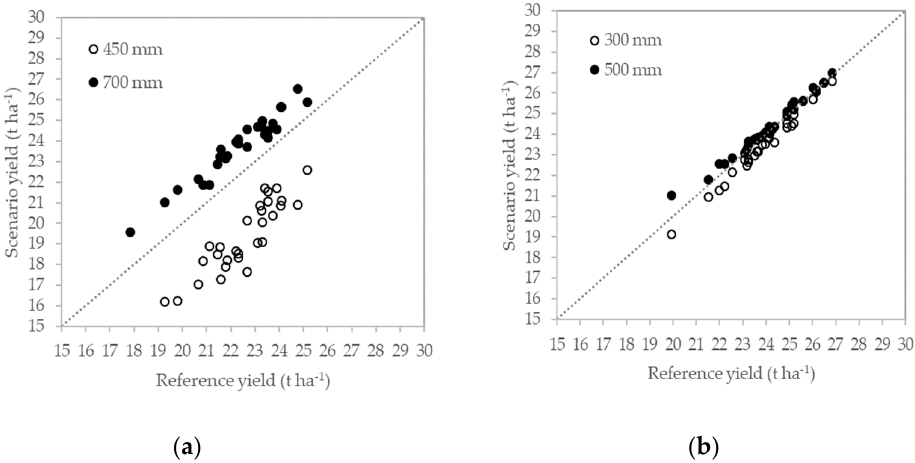
Figure 10. Comparison of potential dry root yield at harvest under different irrigation water allocation scenarios (scenario yield) with potential dry root yield at harvest under the normal irrigation water allocation (reference yield) for the 30 simulated seasons in the two main productive areas: ( a ) North (Valladolid), and ( b ) South (Sevilla).